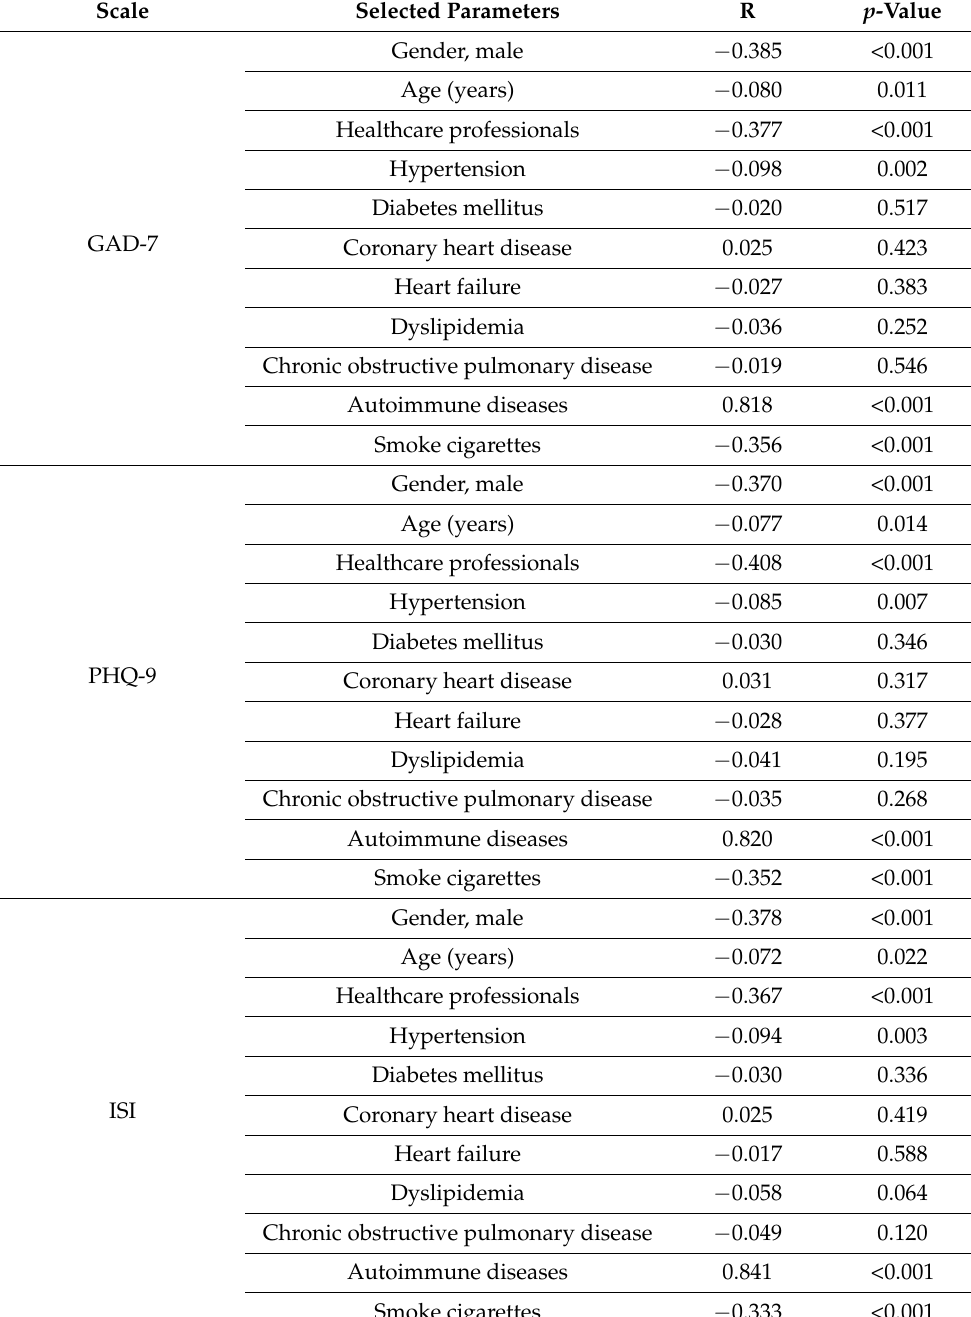
Table 2. Correlation between the ISI, GAD-7, and PHQ-9 scales and selected parameters.